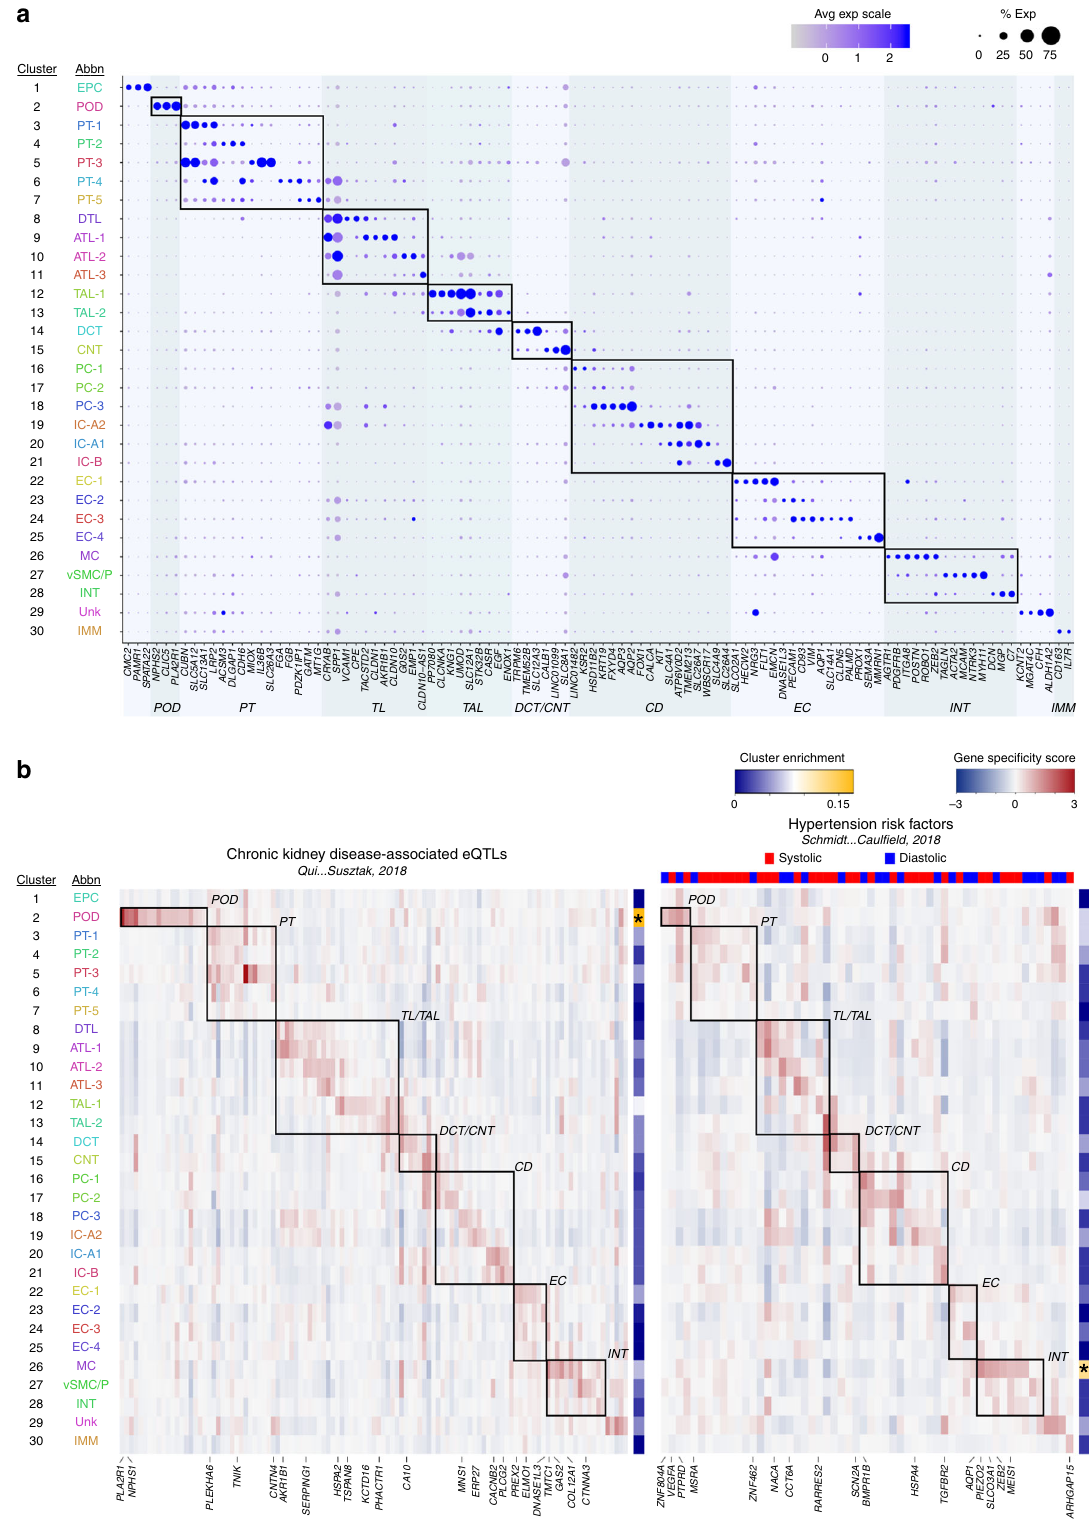
Fig. 2 snDrop-seq clusters show distinct expression pro fi les. a Dot plot of select average gene expression values (log scale) and percentage of nuclei expressing these genes within each cluster (Fig. 1b) for known (bold) and newly discovered cell-type marker genes (see Methods, Supplementary Data 7). b Heatmap showing cluster-speci fi c gene speci fi city scores (see Methods) for differentially expressed genes associated with CKD eQTL 21 and hypertension risk loci 22 (systolic and diastolic blood pressure variants are indicated). The genes corresponding to these clusters are in Supplementary Data 8. Asterisks indicate higher cluster enrichment (proportion of differentially expressed genes associated with each cluster) of CKD-associated eQTLs in POD and hypertension risk factors in MC. Source data are provided as a Source Data fi le. CKD chronic kidney disease, eQTL expression quantitative